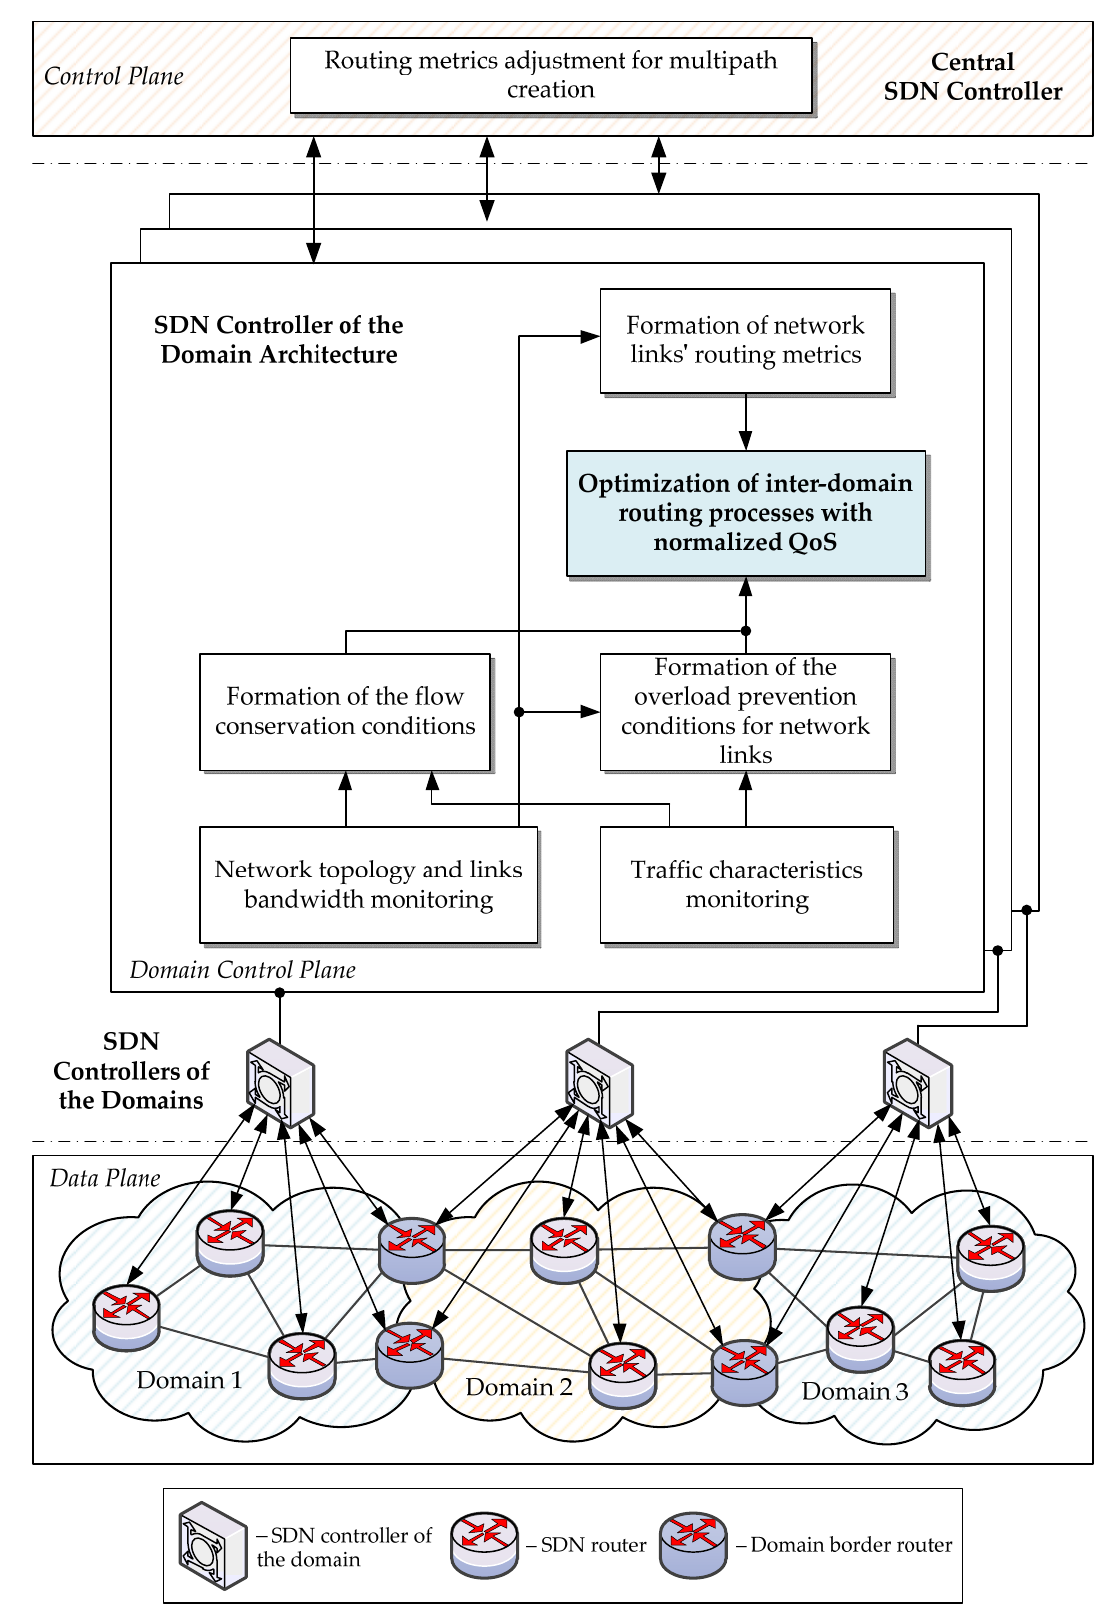
Figure 1. Generalized architecture of hierarchical coordination inter-domain routing with normalized Quality of Service.